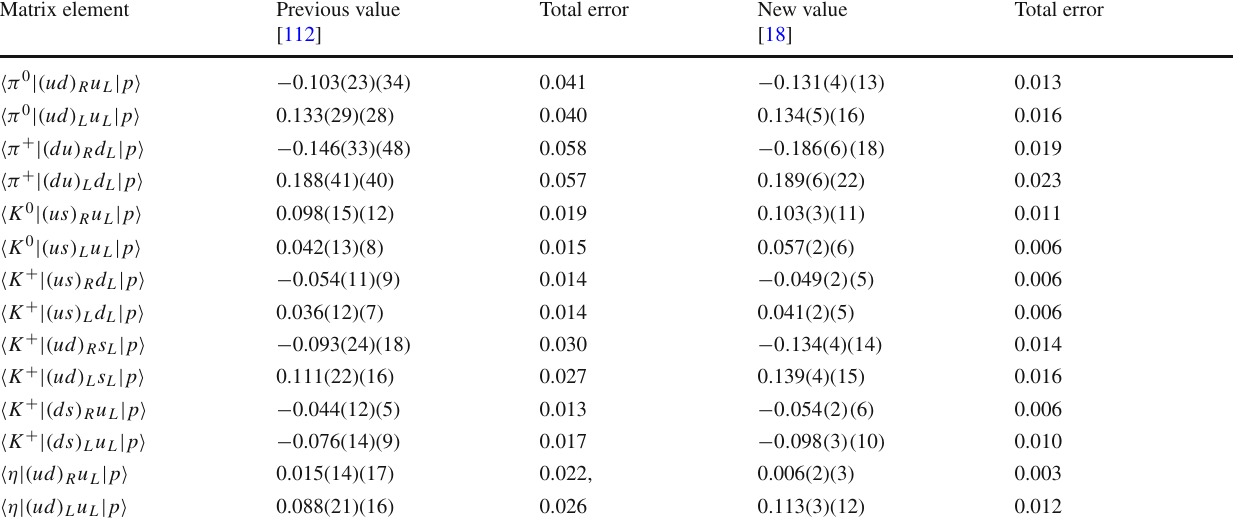
Table 3 Comparison of lattice hadronic matrix element calculations Matrix element Previous value Total error